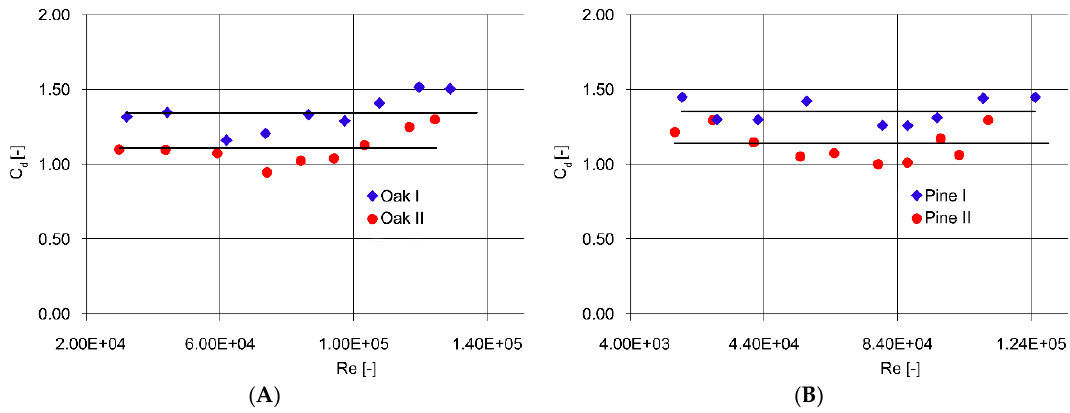
Figure 8. Flow resistance coefficient C d versus Reynolds number Re for oak ( A ) and pine ( B ).